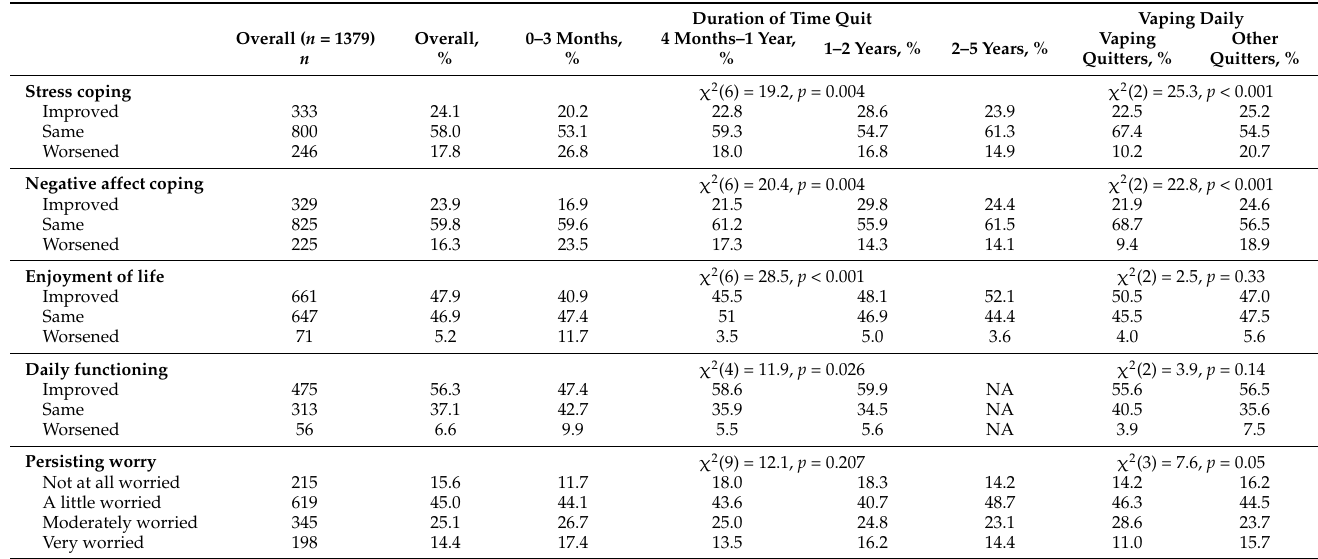
Table 3. Perceived effects of quitting, by duration of time quit and vaping status. Duration of Time Quit Vaping Daily Overall ( n =